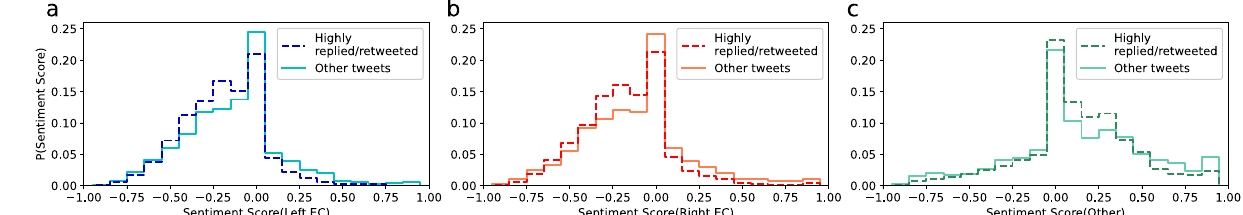
Figure 2. Sentiment score of tweets in left-( a ) and right-leaning ECs ( b ) and other communities ( c ). The distribution of the sentiment score of highly replied/retweeted tweets (replied/retweeted more than 1000 times) and other tweets are plotted in each figure. The sentiment score of a tweet is calculated using the Google Natural Language API 52 for 3,000 sampled tweets of each group.